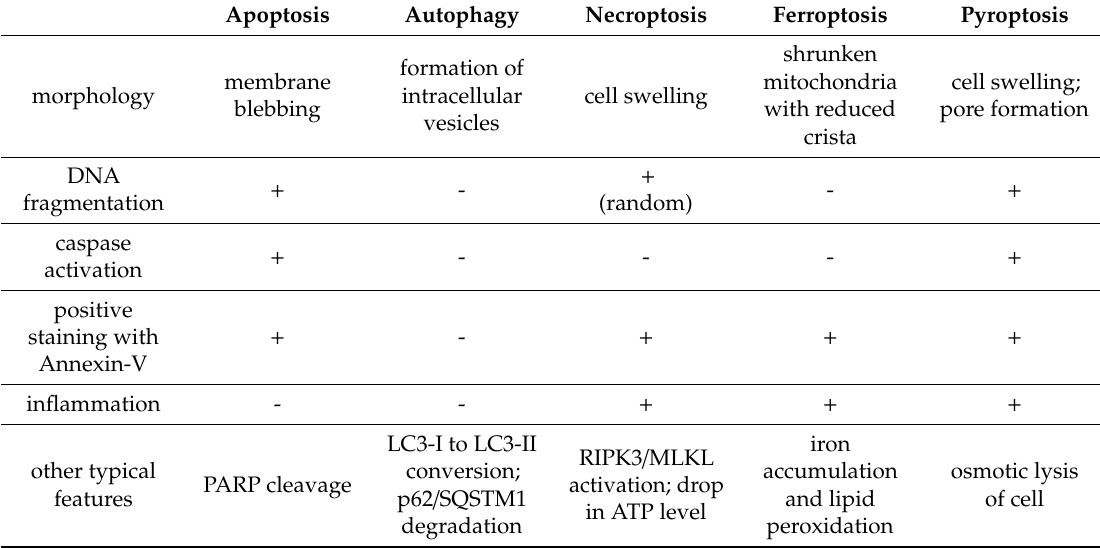
Table 1. The comparison of major morphological and biochemical features and markers of apoptosis and non-apoptotic cell death modalities